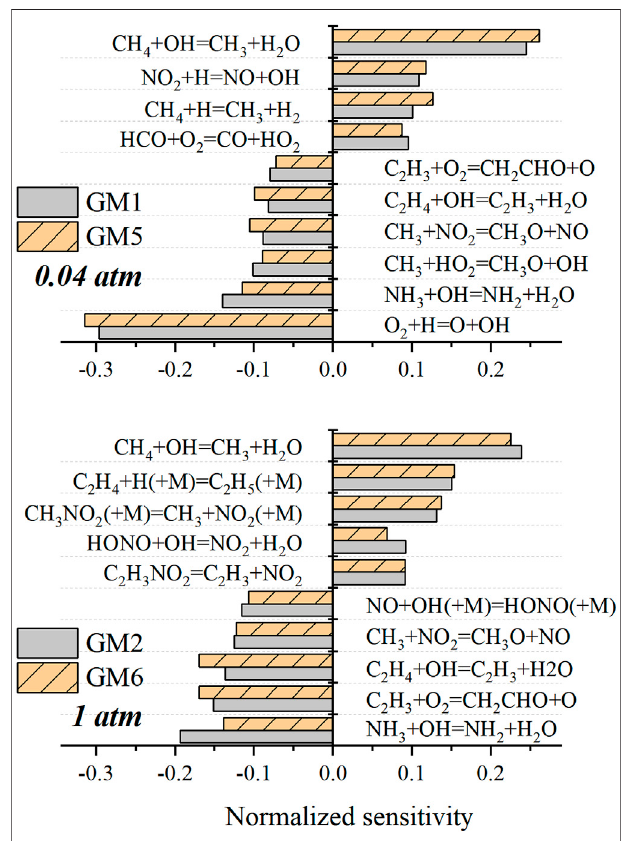
FIGURE 8 | Sensitivity analysis on NH 3 consumption during the fl ow reactor oxidation of GM1, GM2, GM5and GM6 at 1239, 886, 1239, and 886 K,